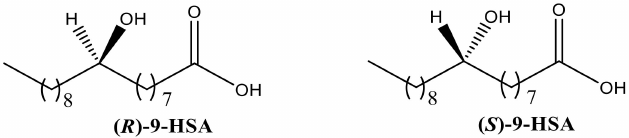
Figure 1. The two enantiomeric forms of 9-hydroxystearic acid, an HDAC inhibitor.